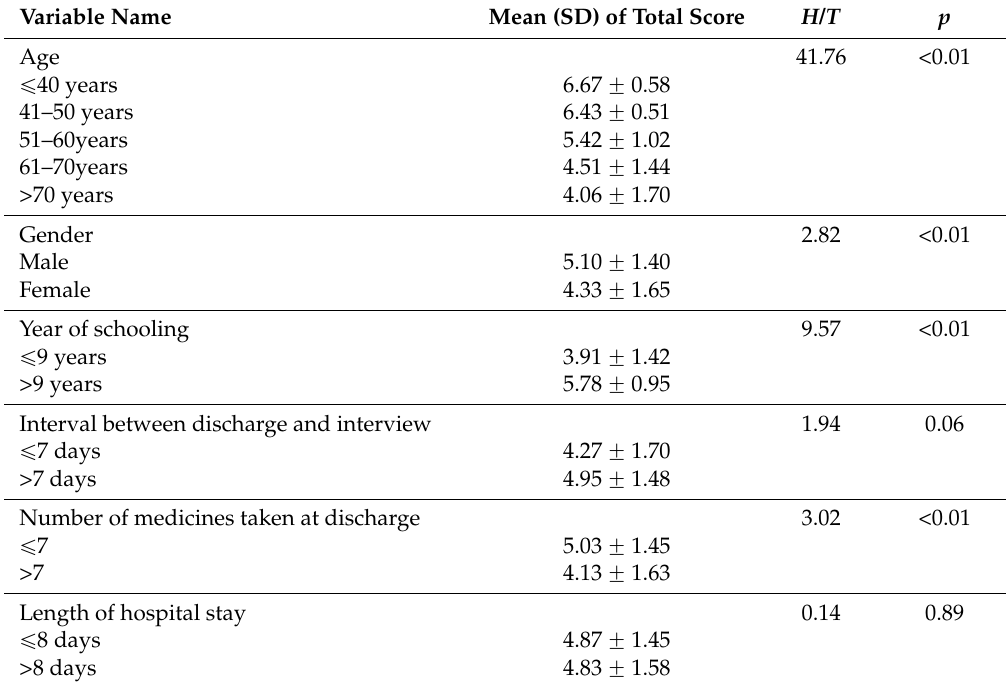
Table 2. Results of univariate analysis of determinants of medication literacy for discharged patients with ACS, Changsha, Hunan, China, March to June 2015 ( n = 153).